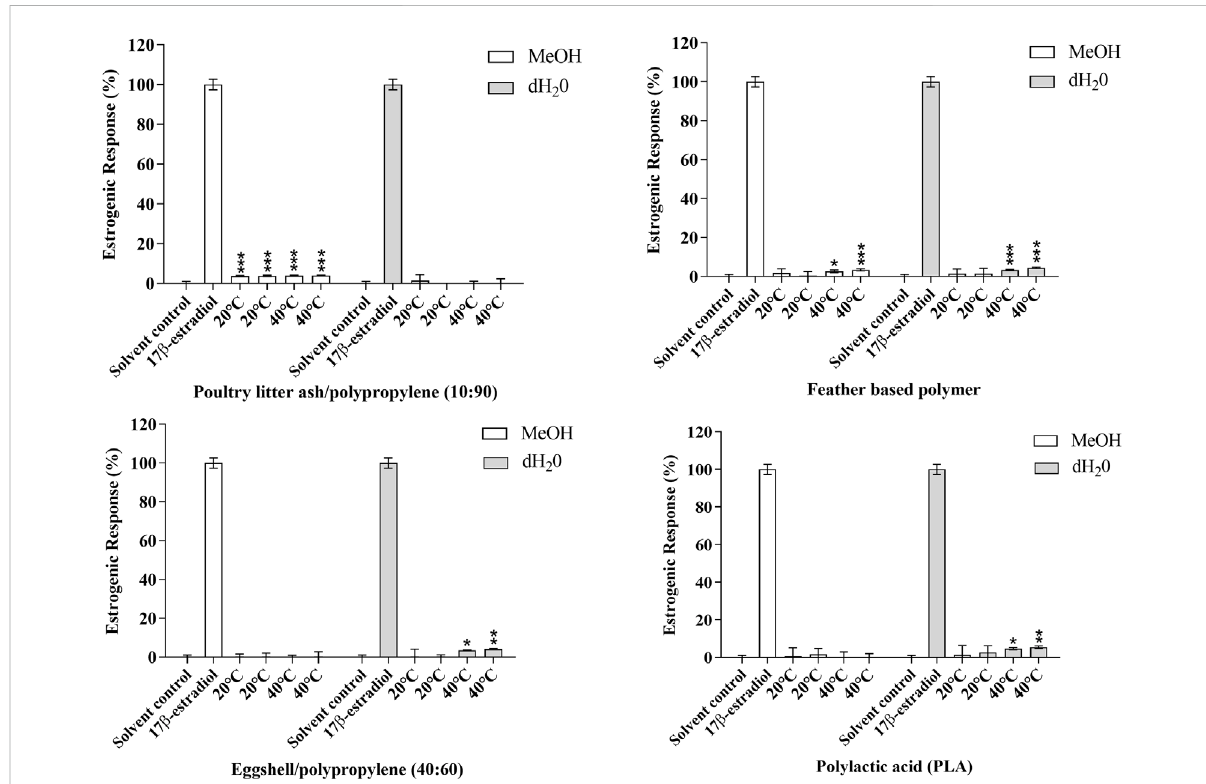
FIGURE 3 Estrogenic agonist response of (A) poultry litter ash/polypropylene (10:90), (B) poultry feather based polymer, (C) eggshell/polypropylene (40: 60) and (D) polylactic acid (PLA) in the MMV-Luc (estrogen responsive) cell line. Responses measured are compared to the solvent control